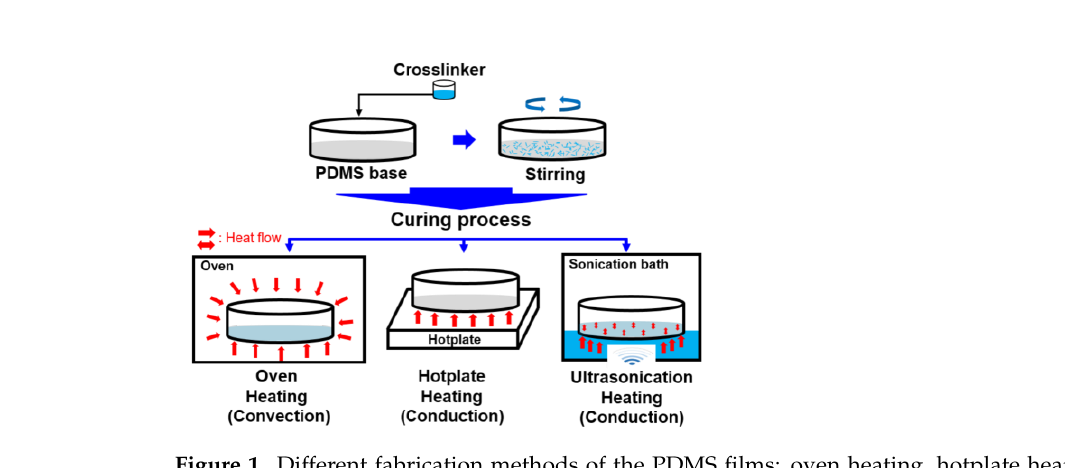
Figure 1. Different fabrication methods of the PDMS films: oven heating, hotplate heating, and ultrasonication heating.